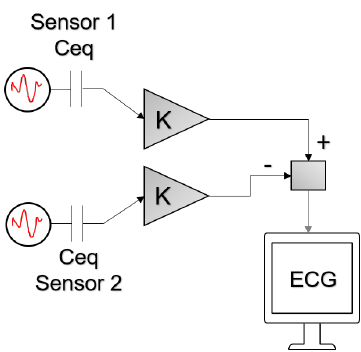
Figure 2. Differential signal path of the skin biopotentials to the display.